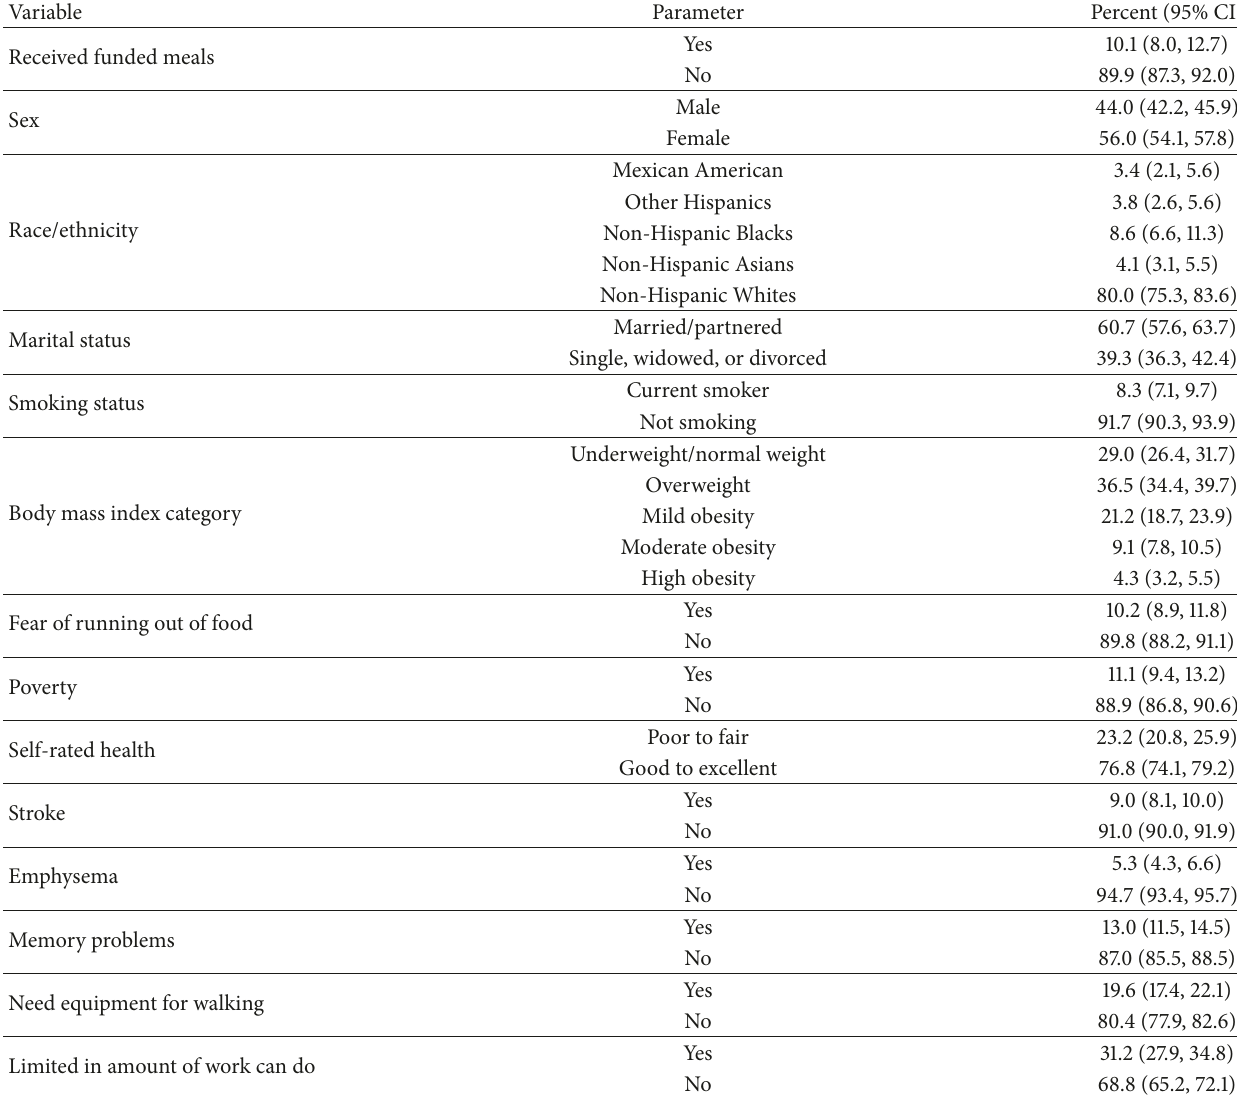
Table 1: Demographics and health issues of the combined sample receiving/not receiving OAA